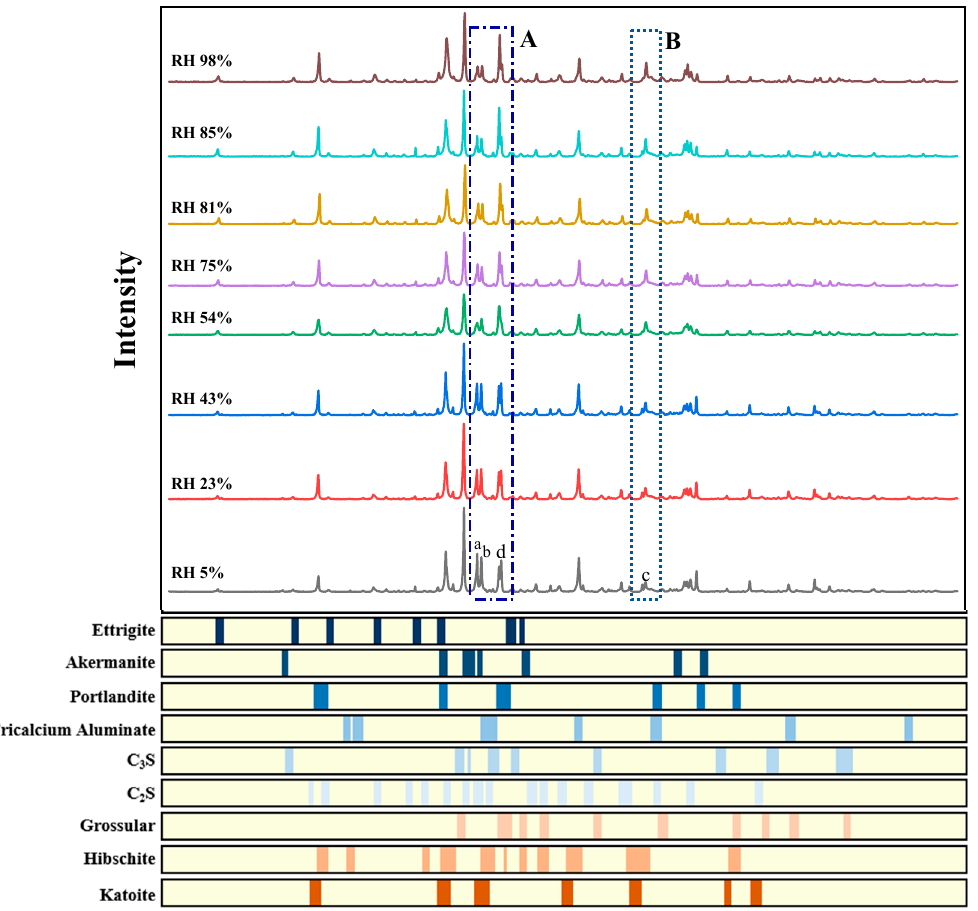
Figure 5. XRD patterns of the samples cured at 20 °C for 7 days at different ambient RHs. (peaks a, b, c, and d represent the peaks of katoite, hibschite, grossular, and portlandite, respectively, and the yellow bands and colored squares below indicate the location of the intensity peaks of each phase according to the ICDD-PDF database).